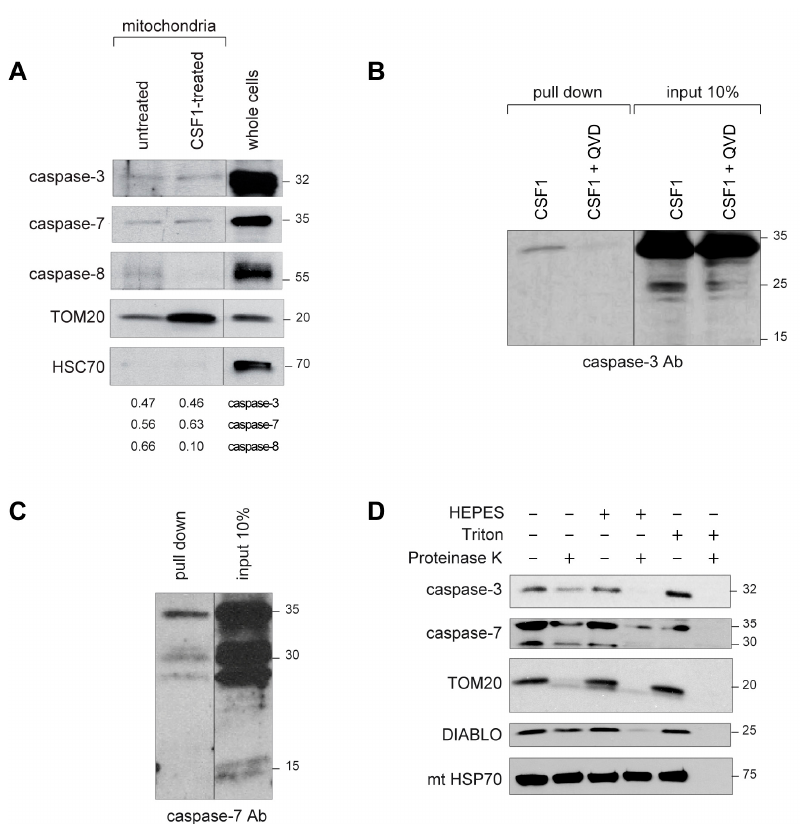
Figure 3. Active forms of caspase-3 and caspase-7 and their localization to the outer mitochondrial membrane. Sorted human monocytes were analyzed before any treatment or after a 4-day exposure to 100 ng/mL CSF-1, with or without 50 µM Q-VD-OPh ( A ) Immunoblot analysis of indicated proteins in lysates of mitochondria sorted from untreated and CSF1-treated monocytes, and in total cell lysates of CSF1-treated cells. ( B , C ) In situ caspase trapping assays performed in CSF-1-treated monocytes in the absence or presence of Q-VD-OPh. Inputs (10%) shown for comparison. Immunoblot detection of active caspase-3 ( B ) and active caspase-7 ( C ) in whole cell lysates and in mitochondrial lysates respectively, using anti-caspase-3 and an anti-caspase-7 antibodies. ( D ) Immunoblot analysis of indicated proteins in mitochondria isolated from CSF-1-treated monocytes and exposed to proteinase K or HEPES or Triton X100. Protein ladder (kDa) is indicated.